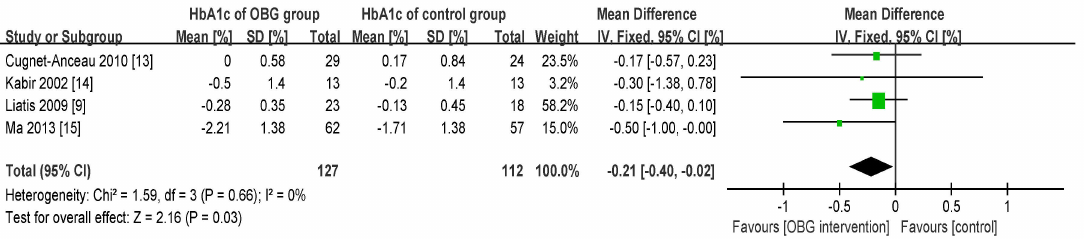
Figure 4. Forest plot for the effect of OBG intake on HbA 1c (%). Data are expressed as mean differences in HbA 1c (%) with 95% confidence intervals (CI). For Ma 2013 [15], FPG concentration is obtained at a dose of 2.5 g/day OBG.